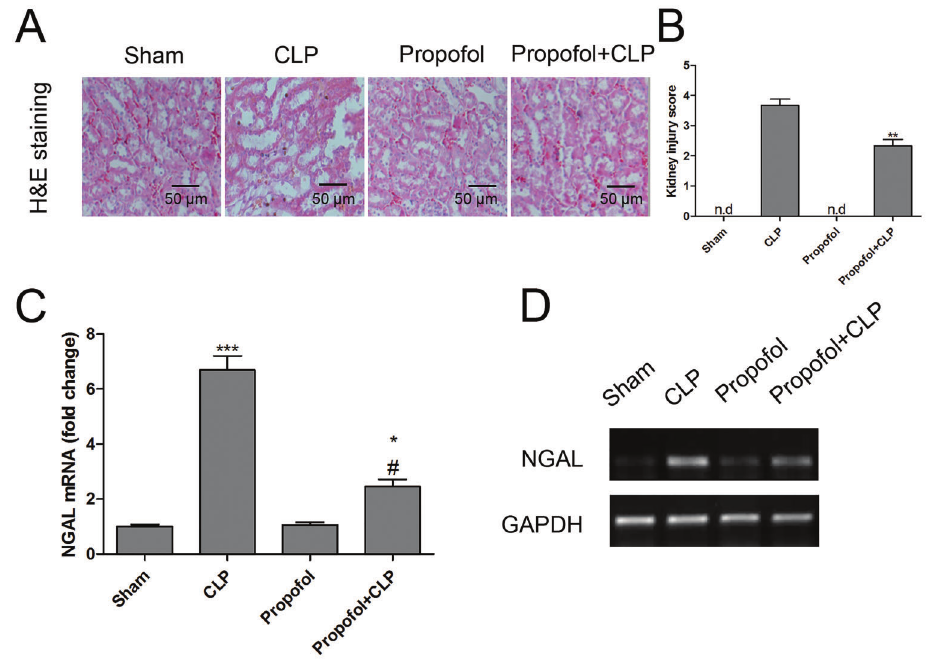
Figure 1. Propofol attenuated cecal ligation and puncture (CLP)-induced acute kidney injury in mice. Twenty-four hours after CLP surgical operation, renal histology (magni fi cation 200 (cid:2) ; A ) and injury score ( B ) were performed in the kidneys from mice with or without propofol treatment. Renal expression of neutrophil gelatinase associated lipocalin (NGAL) mRNA (relative to the controls) was measured by RT-qPCR ( C ) and veri fi ed by agarose gel electrophoresis analysis ( D ). Data are reported as means ± SD (n=12 per group). *P o 0.05, **P o 0.01, ***P o 0.001 compared with the control group; # P o 0.05 compared with the CLP group (ANOVA). nd: not